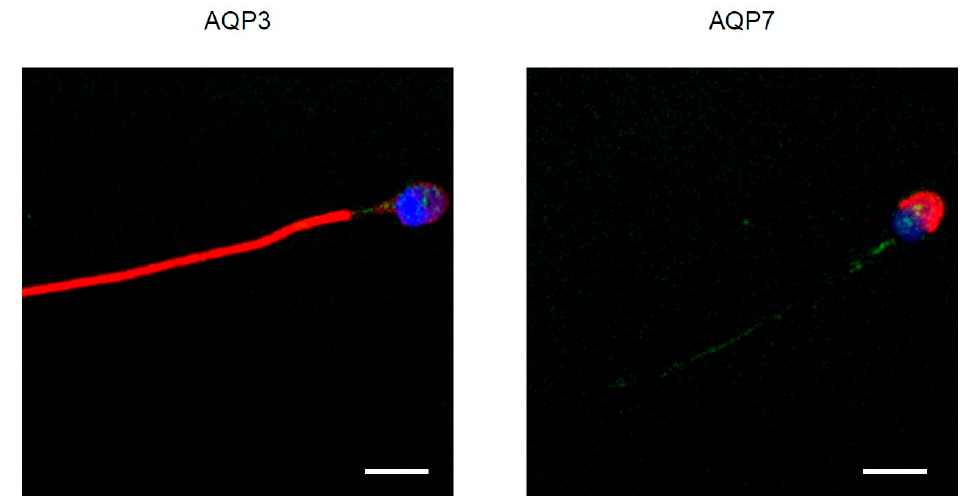
Figure 4. Representative immunofluorescence confocal microscopy images of AQP3, AQP7, and HPV in human sperm. Green labeling indicates the presence of HPV, red labeling the expression of AQP3 or AQP7, while nuclei were counterstained by DAPI (blue). Merged pictures are shown. No colocalization (no yellow signal) was observed for either AQP3 or 7 and HPV. Scale bar, 5 μ m.